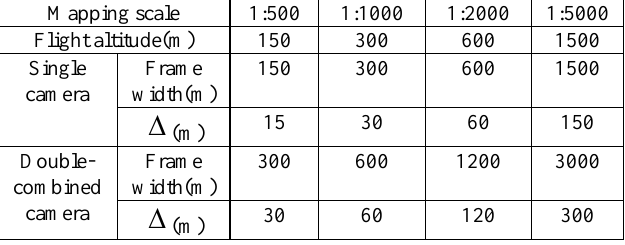
Table 1. The limiting value of  of the longitudinal and lateral overlap